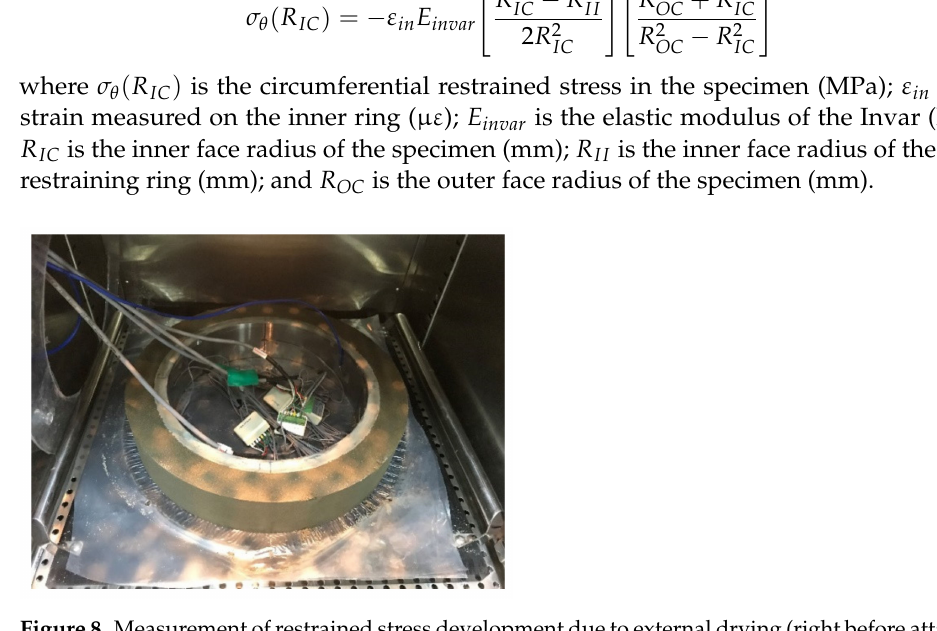
Figure 8. Measurement of restrained stress development due to external drying (right before attaching adhesive-backed aluminum foil on the top